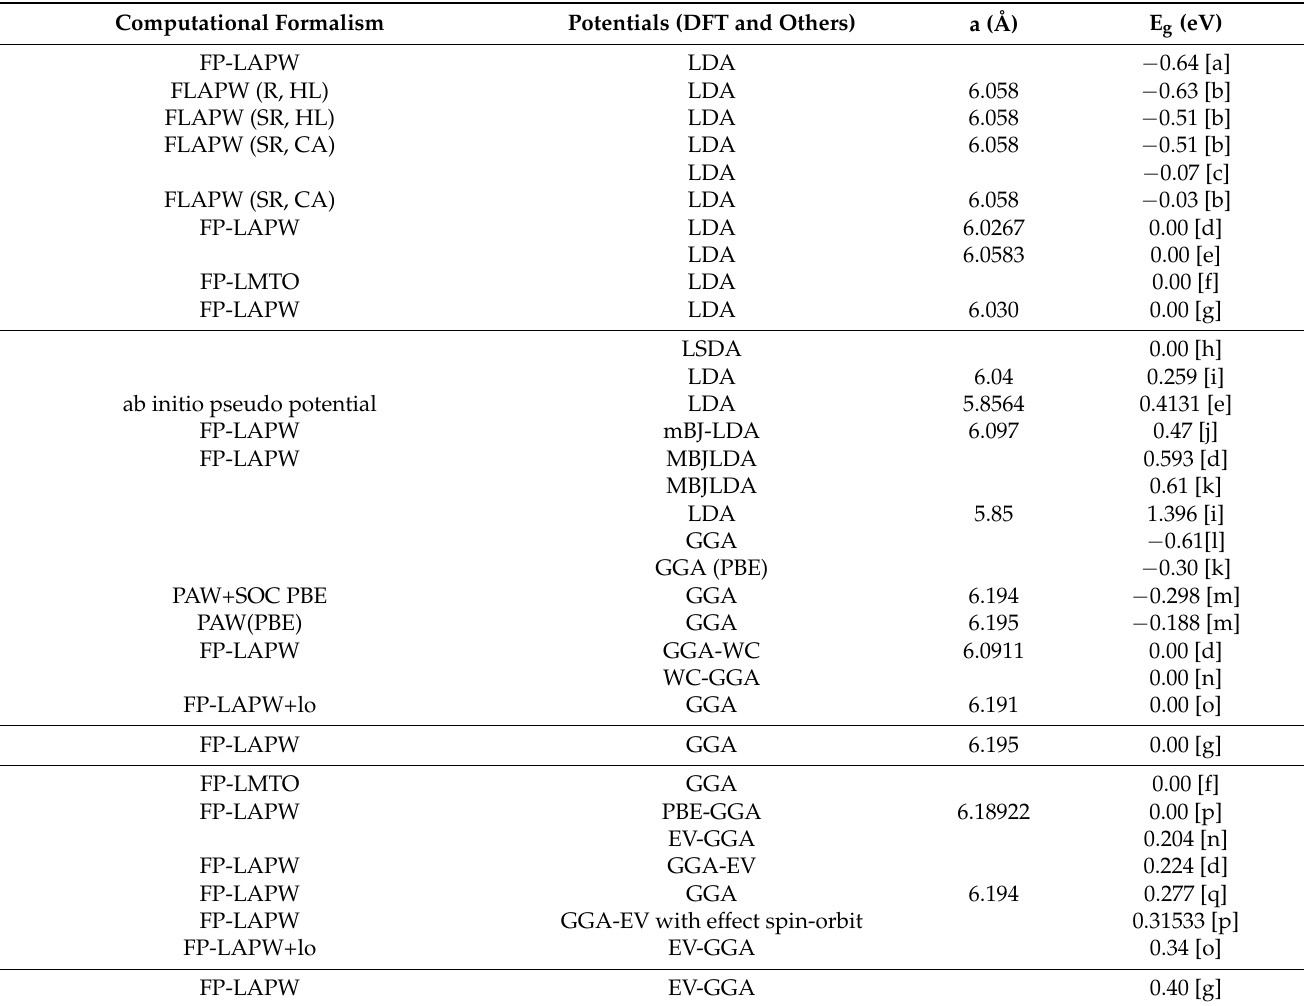
Table 1. Calculated band gaps (E g , in eV) of zinc blende InAs, along with pertinent lattice constants in Angstroms, and experimental values available in the literature. SR = semi-relativistic, R = fully relativistic, CA = Ceperley–Alder, HL =